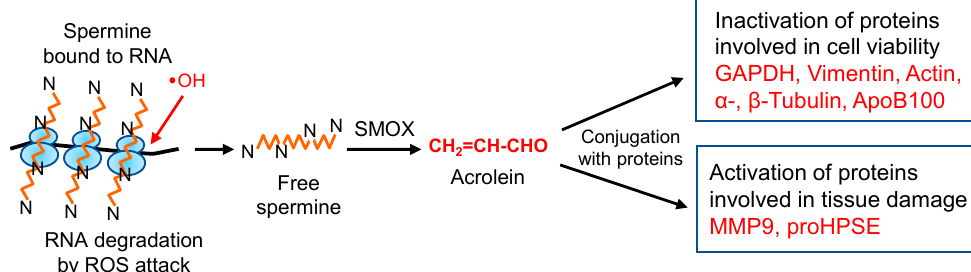
Figure 8. Change of protein activities through acrolein conjugation. In eukaryotic cells, 85% of spermine exists as an RNA–spermine complex in a non-covalent form [63]. When ribosomes are attacked by hydroxyl radicals, one of the ROS, spermine, can be released from ribosomes in a free form. Then, spermine is mainly oxidized to acrolein via 3-aminopropanal by spermine oxidase (SMOX). Produced acrolein modifies proteins, either by activation or by inactivation, resulting in aggravation of diseases.